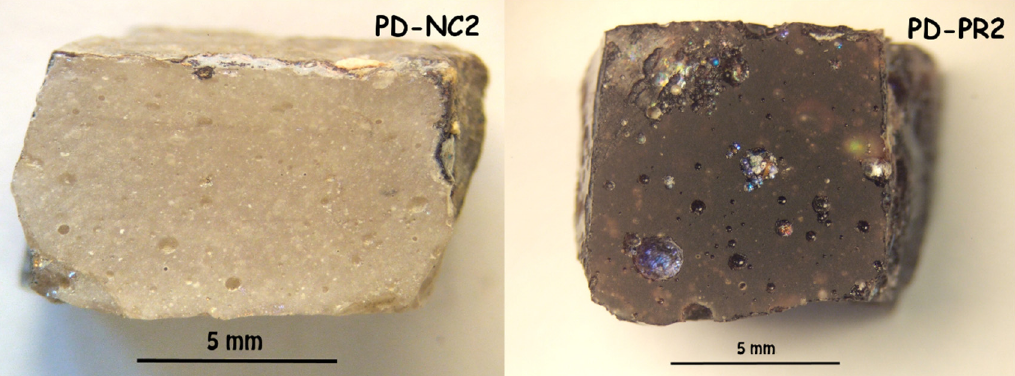
Figure 1. Pictures of two glass tesserae from Padova, representative of the two chromatic groups with manganese ‐ containing inclusions: “Light brown/amber” (PD ‐ NC2) and “purple” (PD ‐ PR2).